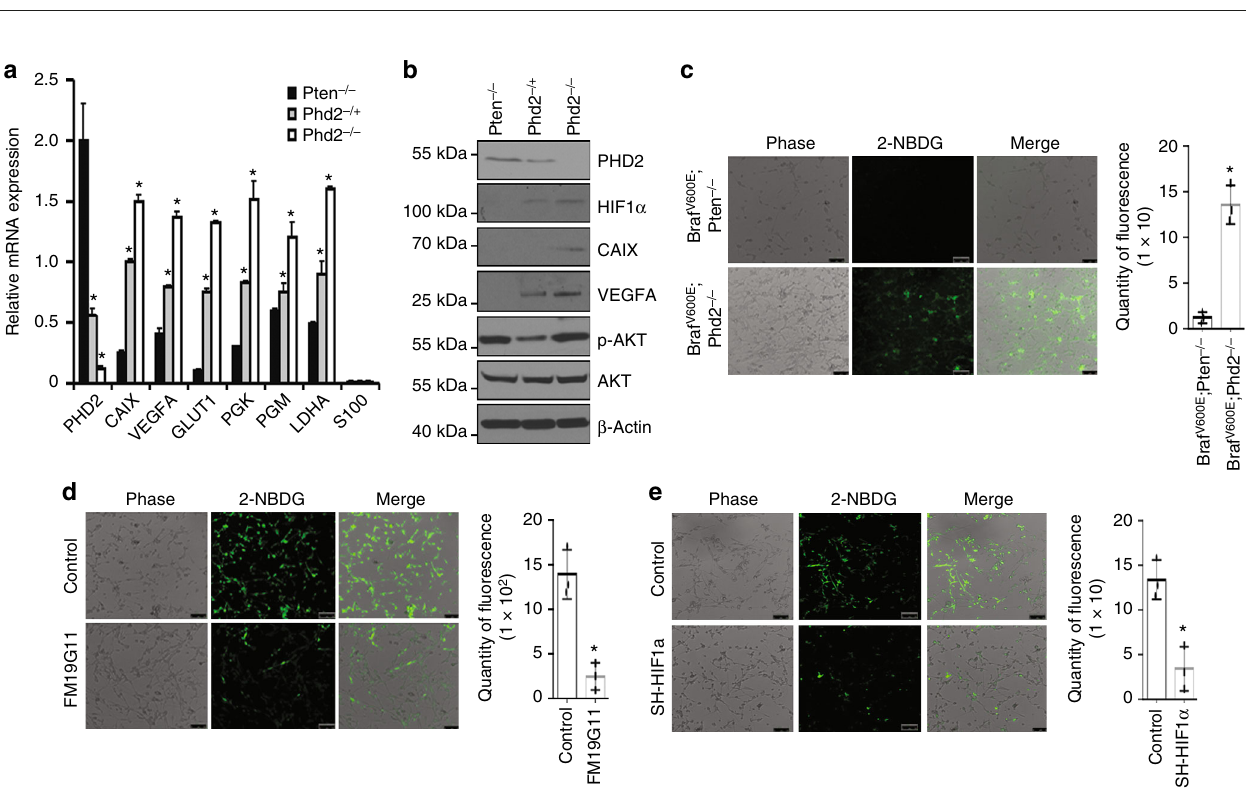
Fig. 5 Phd2 deletion induced HIF target and glucose uptake changes. a Phd2 regulated gene expression in mouse melanomas. Quantitative RT-PCR assay for Phd2 , CAIX , VEGFA , GLUT1 , PGK , PGM and LDHA mRNA expression in Tyr::CreER ; BRaf V600E ; Phd2 − / − mice melanoma tissues ( n = 3 replicate experiments; *p < 0.01 compared with Tyr::CreER; BRaf V600E ; Phd2 − / + or Tyr::CreER; BRaf V600E ; Pten − / − mouse melanoma tissues). β -Actin is used as loading control. b Phd2 regulated protein expression in mouse melanomas. Expression of Phd2, HIF-1 α , VEGFA, pAkt and Akt protein was determined by western blot